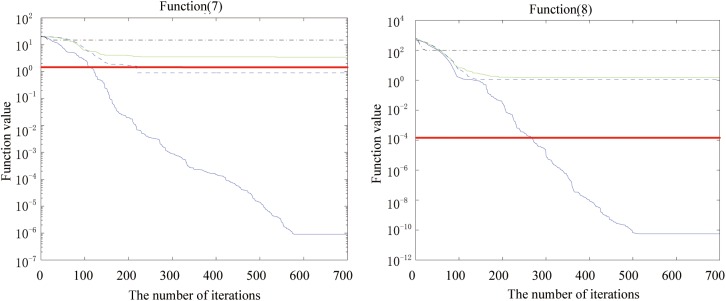
The fitness value of various algorithms for Ackley and Griewank during increasing iterative times.